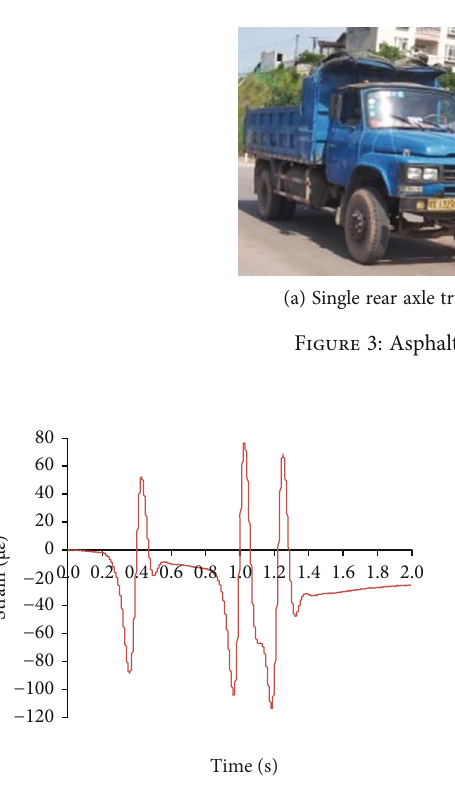
Figure 4: Truck loads move far away from the sensor